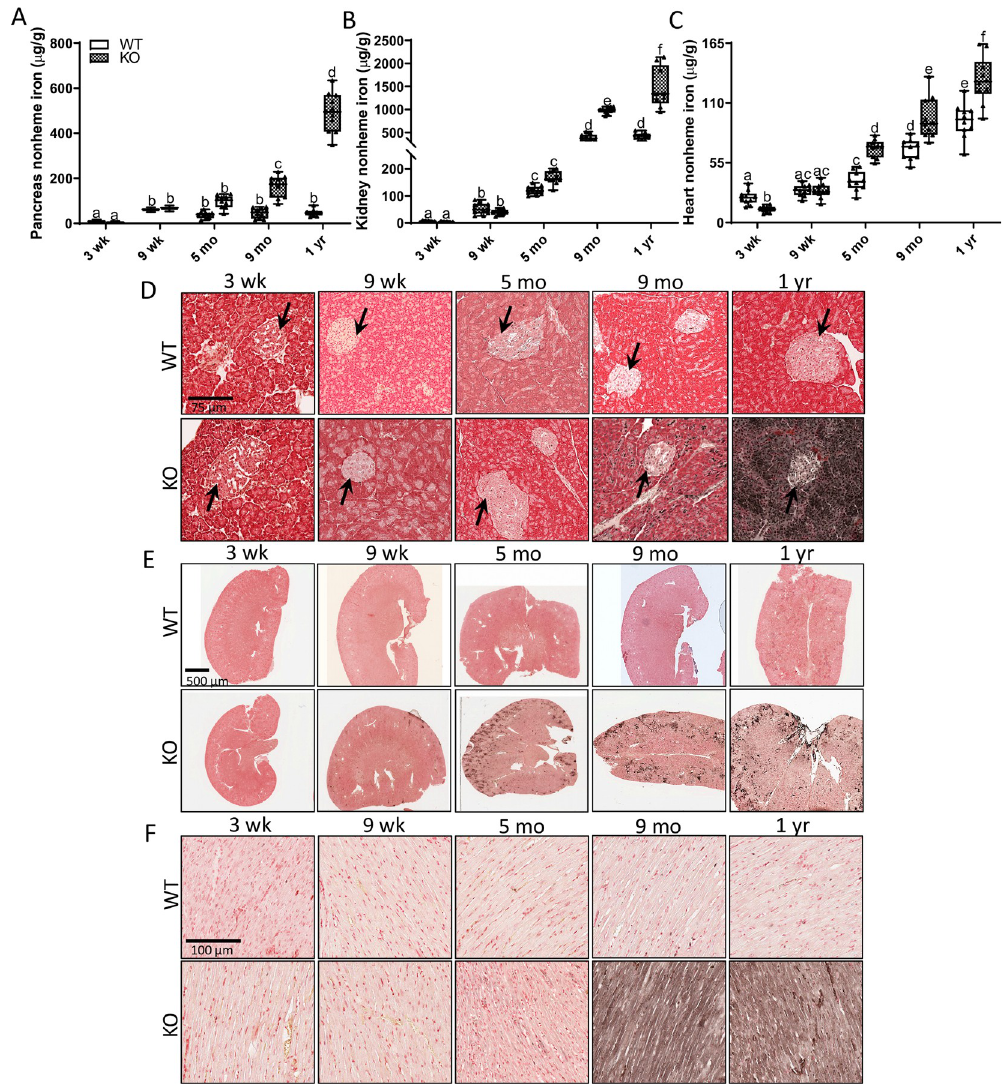
Fig 9. Male Hamp -/- rats display progressive iron loading in extra-hepatic tissues. To characterize the chronology of iron loading in various tissues, nonheme iron concentrations were quantified and Perls’ Prussian blue iron staining was performed in samples collected from rats of both genotypes at different ages. Nonheme iron levels in the pancreas, kidney and heart are shown in panels A-C . Data are presented as box plots for n = 9–10 rats/group. All data were log transformed before being analyzed by 2-way ANOVA followed by Tukey’s multiple comparisons test; however, untransformed data are presented for ease of interpretation. Groups without a common letter differ significantly ( p < 0.043). Genotype × Age, p < 0.0007; Genotype, p < 0.022; Age, p < 0.001 ( A-C ). Representative images are also shown from iron-staining experiments using paraffin-embedded sections derived from the pancreas ( D ), kidney ( E ), and heart ( F ) of male WT and Hamp -/- rats at various ages (n = 6 per group). In panel D , arrows indicate pancreatic islets (note iron deposits within the islets of older KOs).